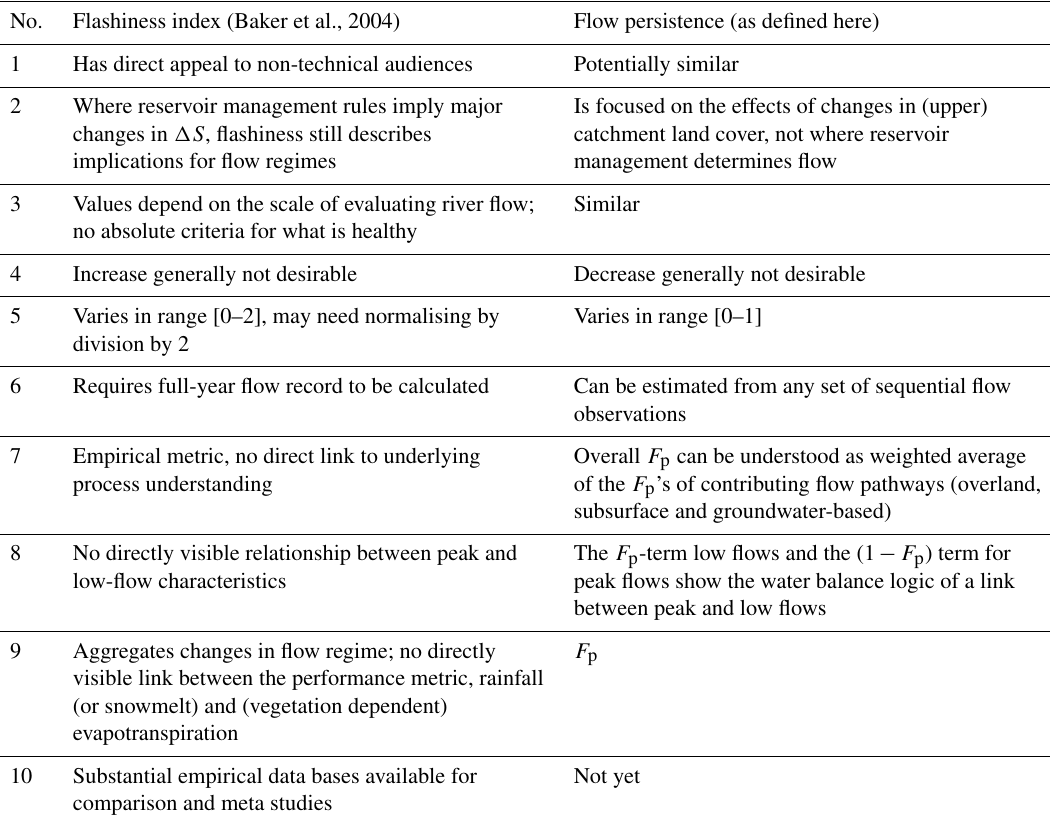
Table 1. Comparison of properties of the flashiness index and flow persistence F p